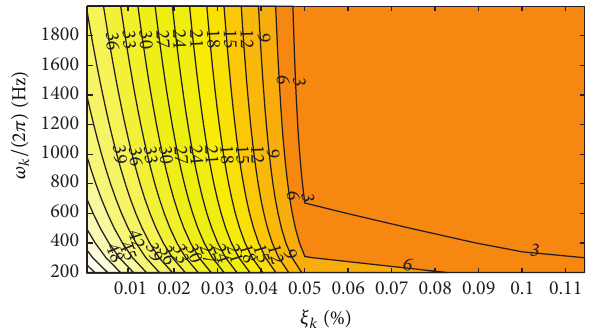
Figure 16: Perf |𝑇 𝑧𝑤 | max as function of 𝜉 𝑘 and 𝜔 𝑘 for 𝜓 2 𝑘 𝛾 Table 4).